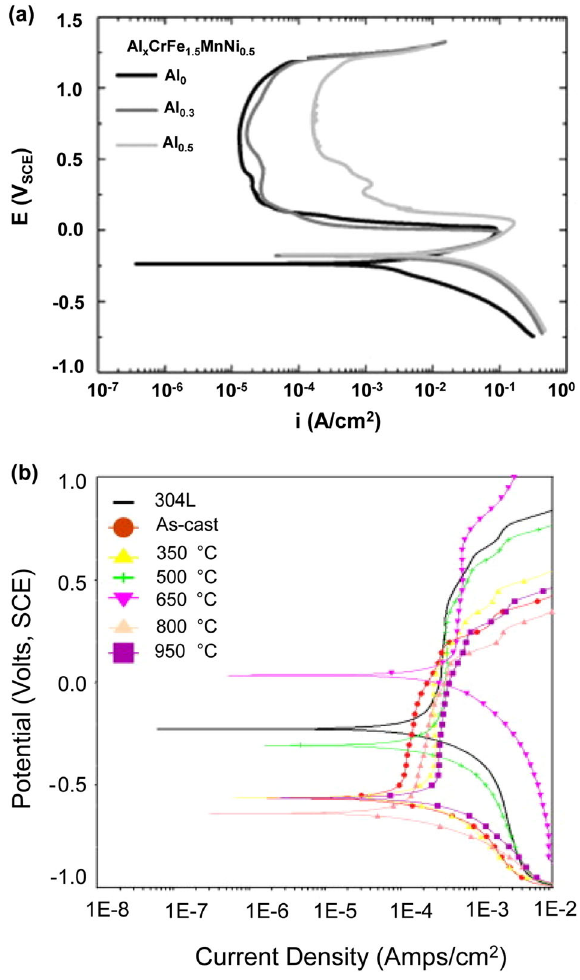
Fig. 14 a Effect of aluminium content in the Al x CrFe 1.5 MnNi 0.5 ( x = 0, 0.3 and 0.5) system as determined by potentiodynamic polarisation curves in 15% H 2 SO 4 solution. b The potentiodynamic polarisation curves of as-cast and aged Al 0.5 CoCrFeNi alloy specimens in 3.5 % NaCl solution at 25 °C ( a reprinted from ref. 70 with permission from Elsevier; b reprinted from ref. 73 with permission from Elsevier) Published in partnership with CSCP and